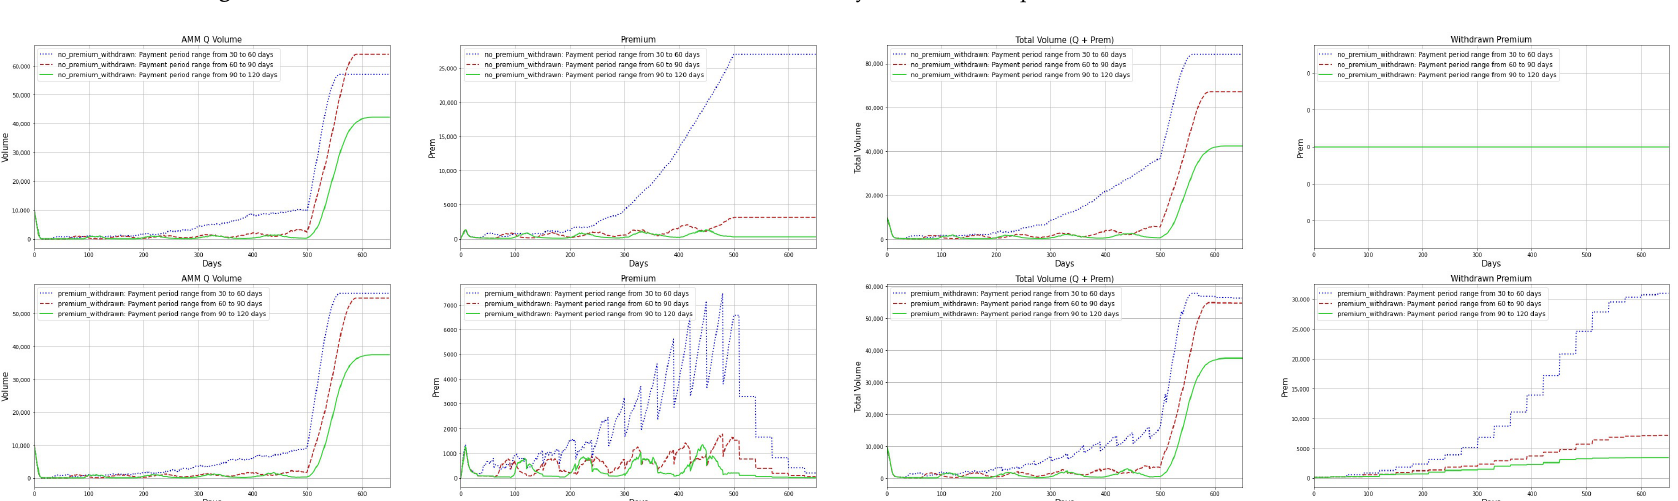
Figure A7. rkAMM Curves from simulation of scenario 3 and 1 day of withdrawal period.